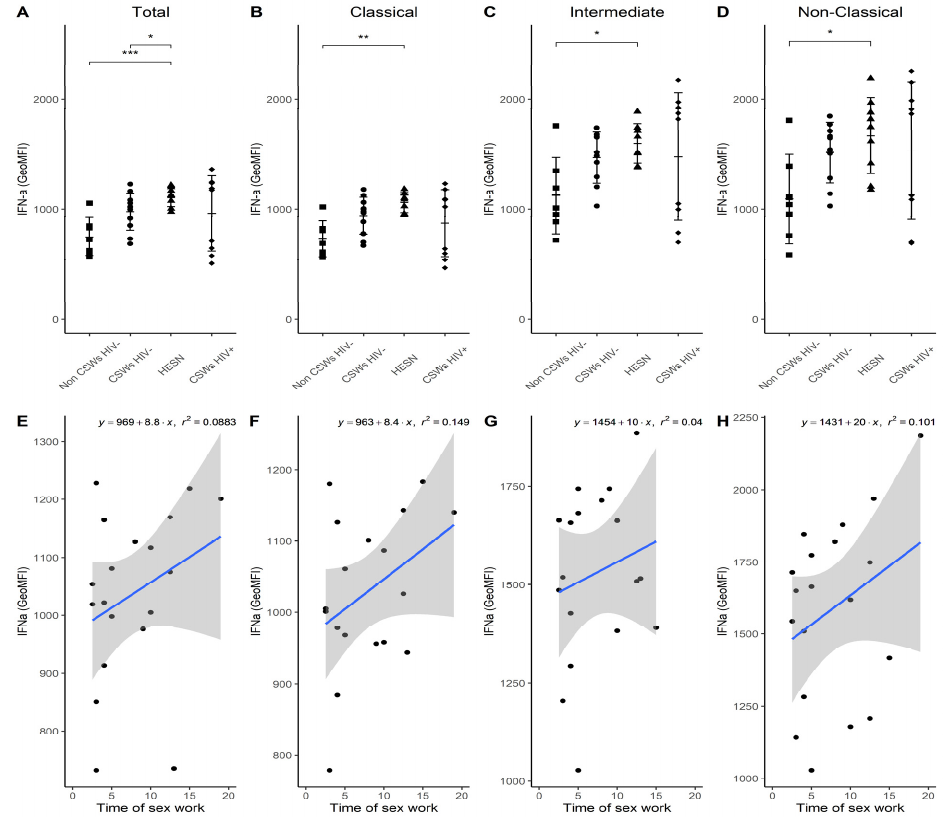
Figure 6. Flow cytometry analyses of IFN- α expression levels by live blood monocyte popula- tions. ( A – D ) Levels of expression of ex vivo IFN- α proteins, as determined by geometric mean fluorescence intensity (GeoMFI), by ( A ) CD14+ total, ( B ) CD14+CD16 − classical, ( C ) CD14+CD16+ intermediate, and ( D ) CD14 low/dim CD16++ non-classical monocytes. Data are presented as the mean value ± SD of samples from 7 non-CSWs HIV- (HIV-1-uninfected control women from the gen- eral population), 9 CSWs HIV- (HIV-1-uninfected 2.5–5-year CSWs “early HESNs”), 11 HESNs (HIV-1-uninfected ≥ 10 years CSWs), and 9 CSWs HIV+ (HIV-1-infected CSWs). Significance levels are shown as * ( p < 0.05), ** ( p < 0.01), *** ( p < 0.001). ( E – H ) Linear regression analy- ses are shown for CSWs HIV- (HIV-1-uninfected 2.5–5-year CSWs “early HESNs”) and HESNs (HIV-1-uninfected ≥ 10 years